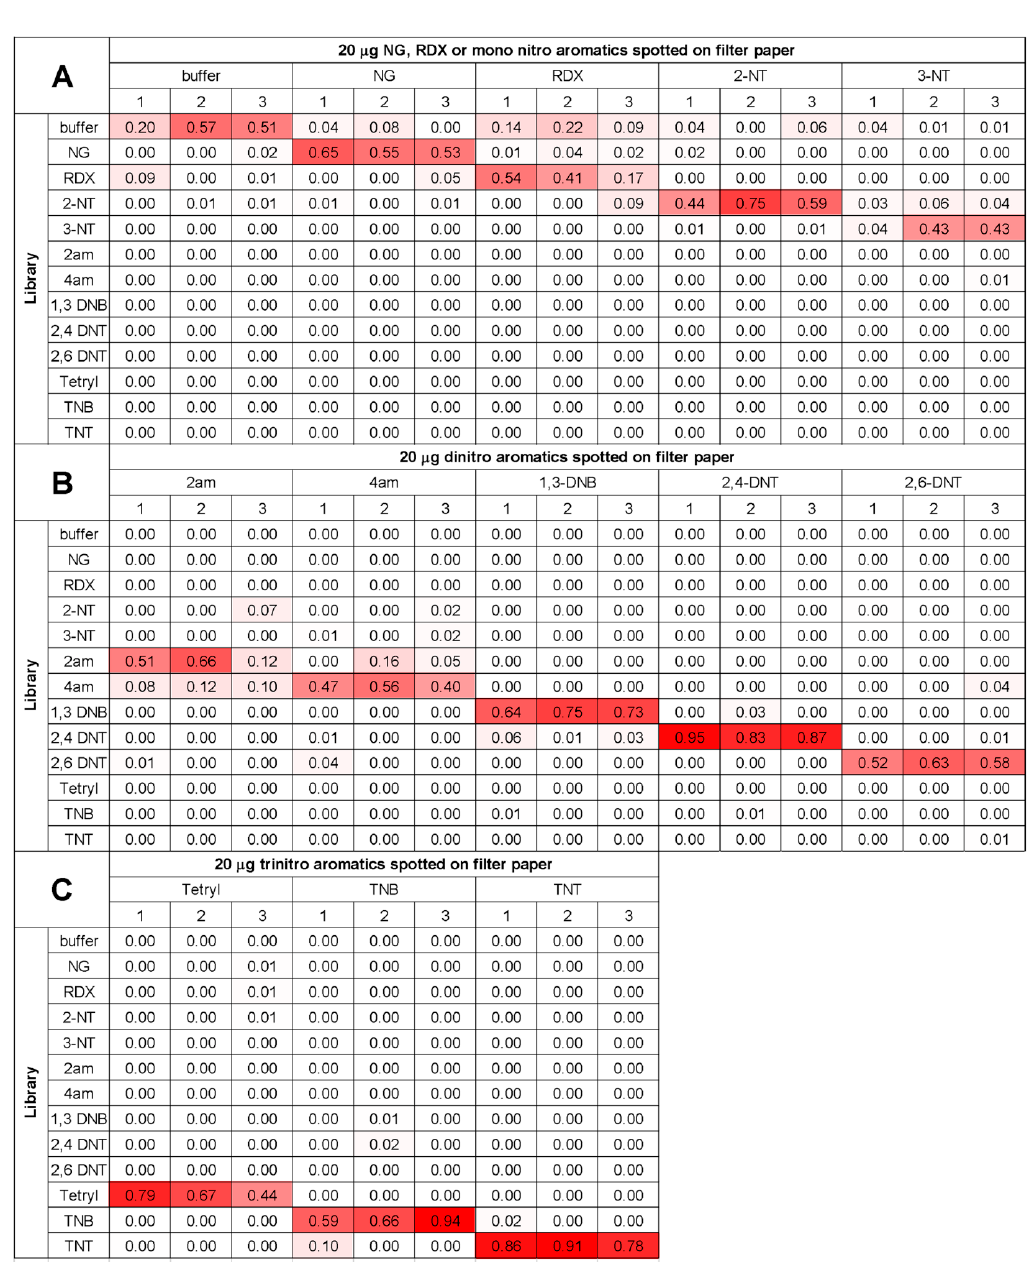
Figure 4. Score charts of each explosive compared to the library. ( A ) 20 µg of NG, RDX, or NT spotted onto filter paper. ( B ) 20 µg of di-nitroaromatics spotted onto filter paper. ( C ) 20 µg of tri-nitroaromatics spotted onto filter paper.